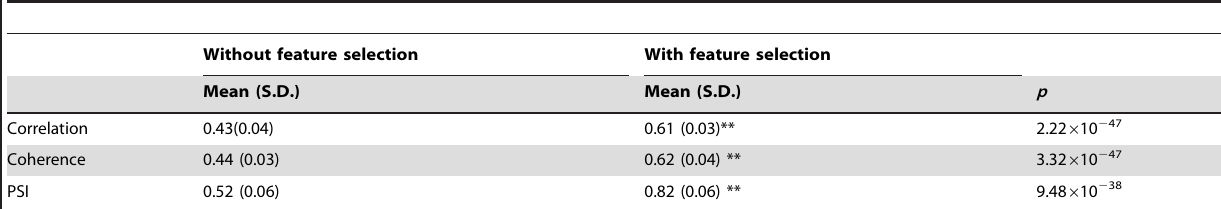
Table 7. Comparison of Classification Accuracy by Using All Frequency Bands Base on Correlation, Coherence and Phase Synchronization Index (PSI) With and Without Feature